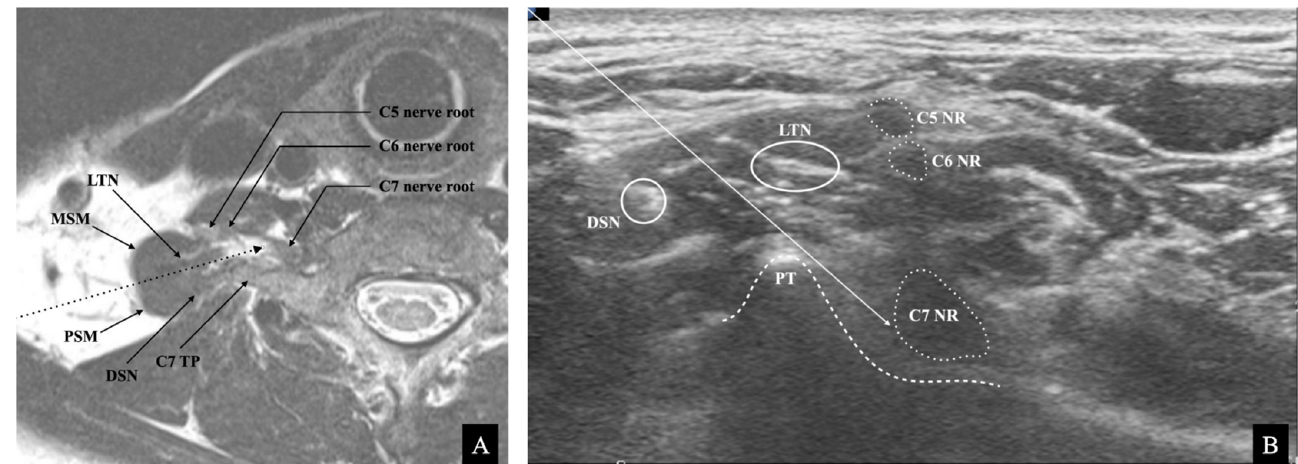
Figure 1. The needle’s trajectory and anatomical relationship of the long thoracic nerve (LTN) and dorsal scapular nerve (DSN) during the ultrasound-guided C7 selective nerve root block (SNRB). ( A ) A T2-weighted magnetic resonance image around the C7 nerve root. The needle’s trajectory (dotted arrow) during the C7 SNRB pierces the middle scalene muscle (MSM). The LTN is near the trajectory within the MSM. The dorsal scapular nerve (DSN) around the posterior scalene muscle (PSM) is away from the trajectory. ( B ) The ultrasound image of the C7 SNRB. The needle’s trajectory (arrow) goes over the posterior tubercle (PT) of the C7 transverse process and reaches the C7 nerve root (NR). The LTN is located near the trajectory, and the DSN is behind the PT away from the trajectory.